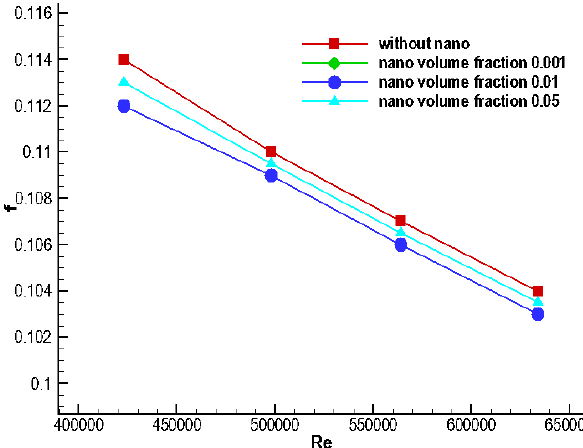
Fig. 15. Friction factor for various particle volume Fig .15 Friction factor for various particle volume concentrations